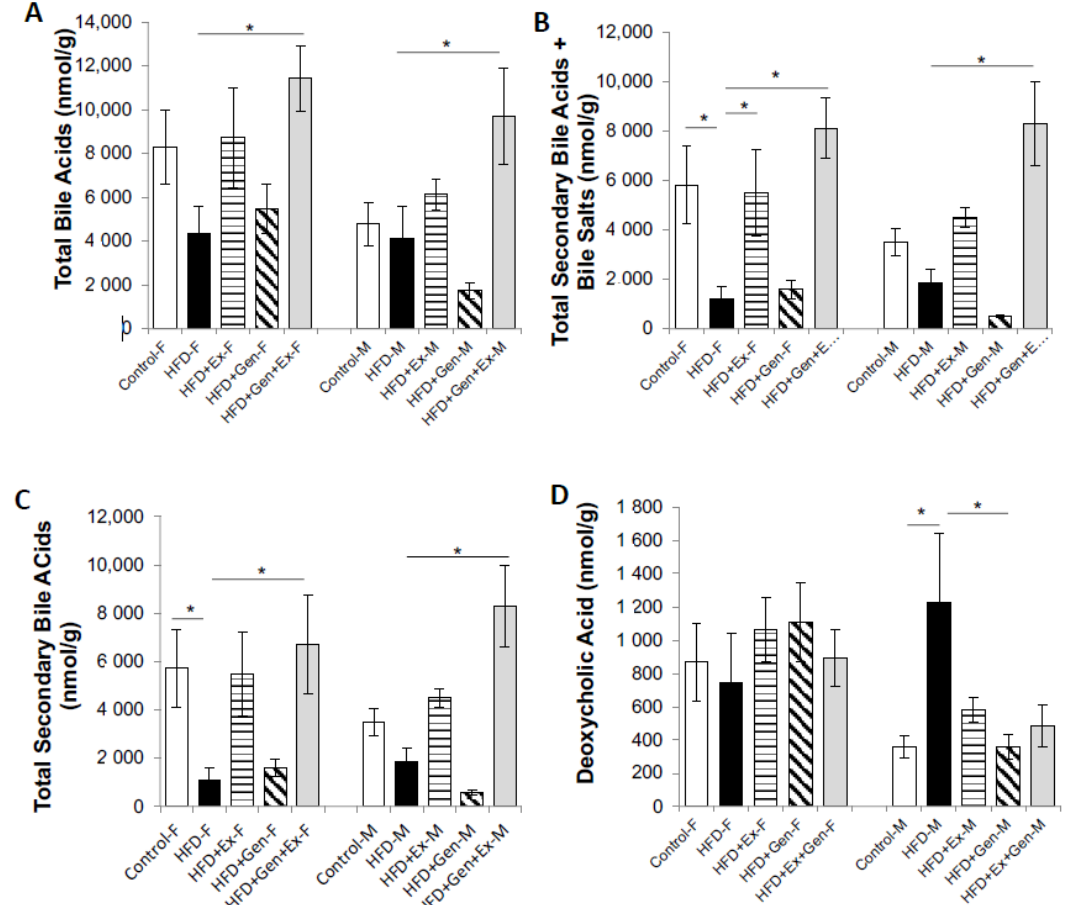
Figure 7. Fecal ( A ) total bile acid concentration (nmol / g); ( B ) total secondary bile acid + bile salt concentration (nmol / g); ( C ) total secondary bile acids (nmol / g); ( D ) deoxycholic acid concentration (nmol / g) in feces. Significant group di ff erences ( p < 0.05) were assessed by one-way ANOVA with multiple Dunnett’s comparisons. * denotes significant di ff erence ( p < 0.05). HFD, high-fat, high-sugar diet; Exe, exercise; Gen, genistein; F, female; M, male.